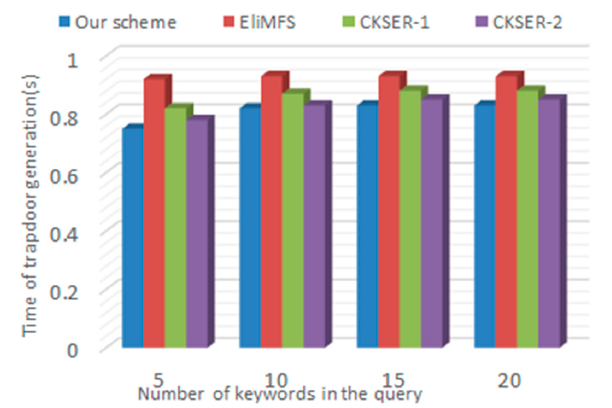
Figure 9. Time of trapdoor Generation.